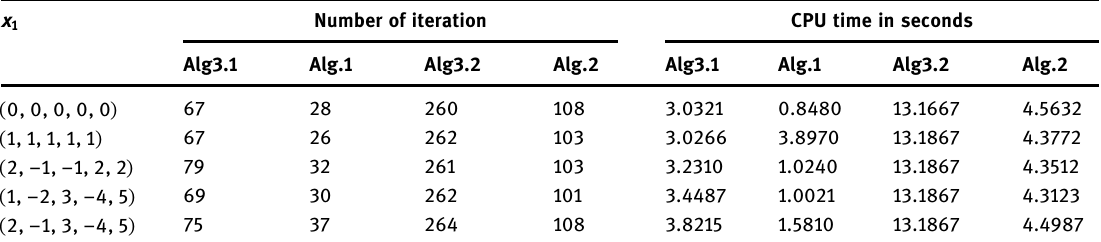
Table 2: Example 6.2: Algorithmic comparison of Algorithms 1 – 2 with Algorithms 3.1 – 3.2 in [ 31